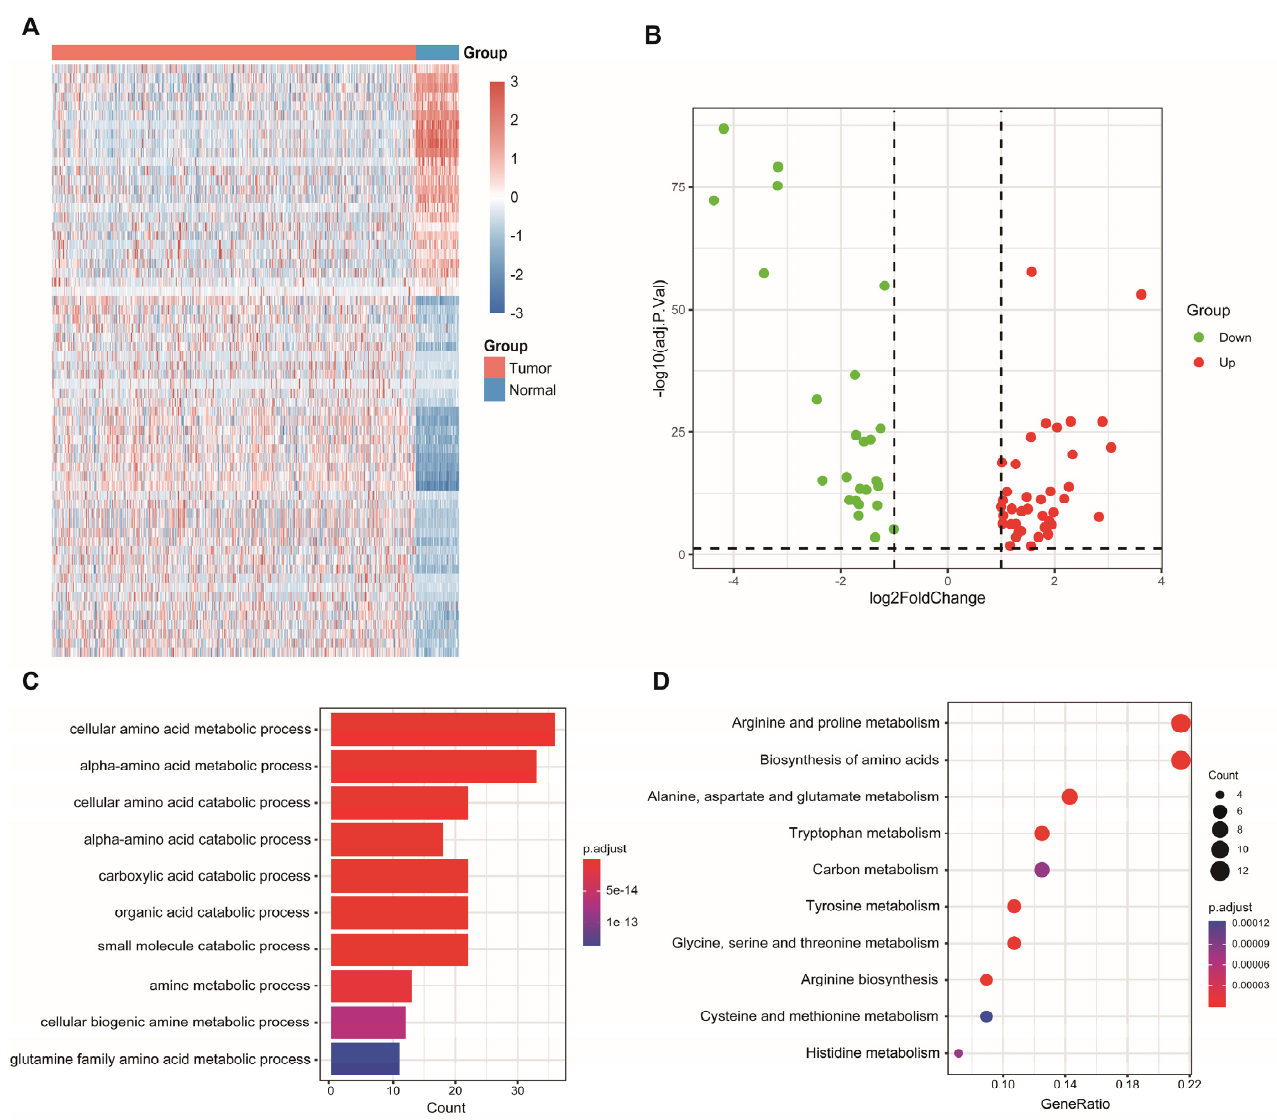
Figure 1. Identification and enrichment analysis of AAM-related genes in LUAD. ( A ) Heatmap showing 64 differentially expressed AAM-related genes in LUAD and normal tissues. ( B ) Volcano plot exhibiting 25 downregulated and 39 upregulated genes. ( C ) GO enrichment analysis. ( D ) KEGG pathway enrichment analysis.